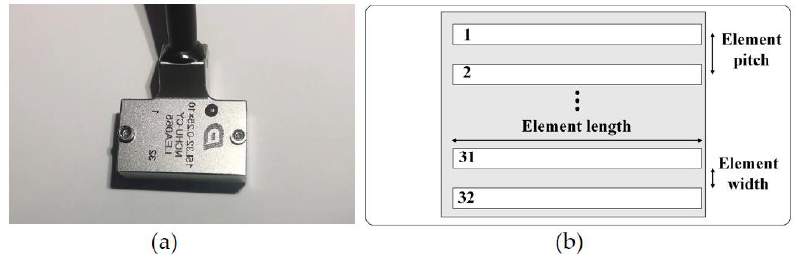
Figure 5. Linear array ultrasonic transducer. ( a ) Ultrasonic transducer and ( b ) array distribution diagram. Table 1. Parameters of Phased Array.